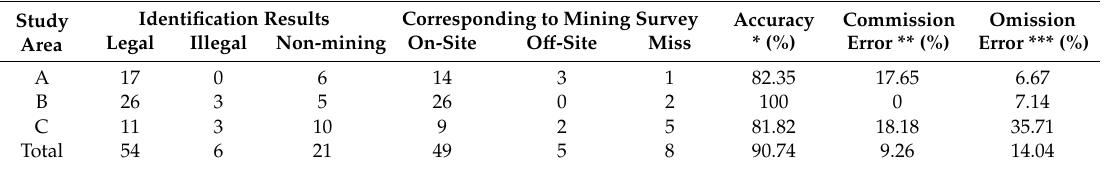
Table 3. Identification results and verification statistics for mining sites in the three study areas. Study